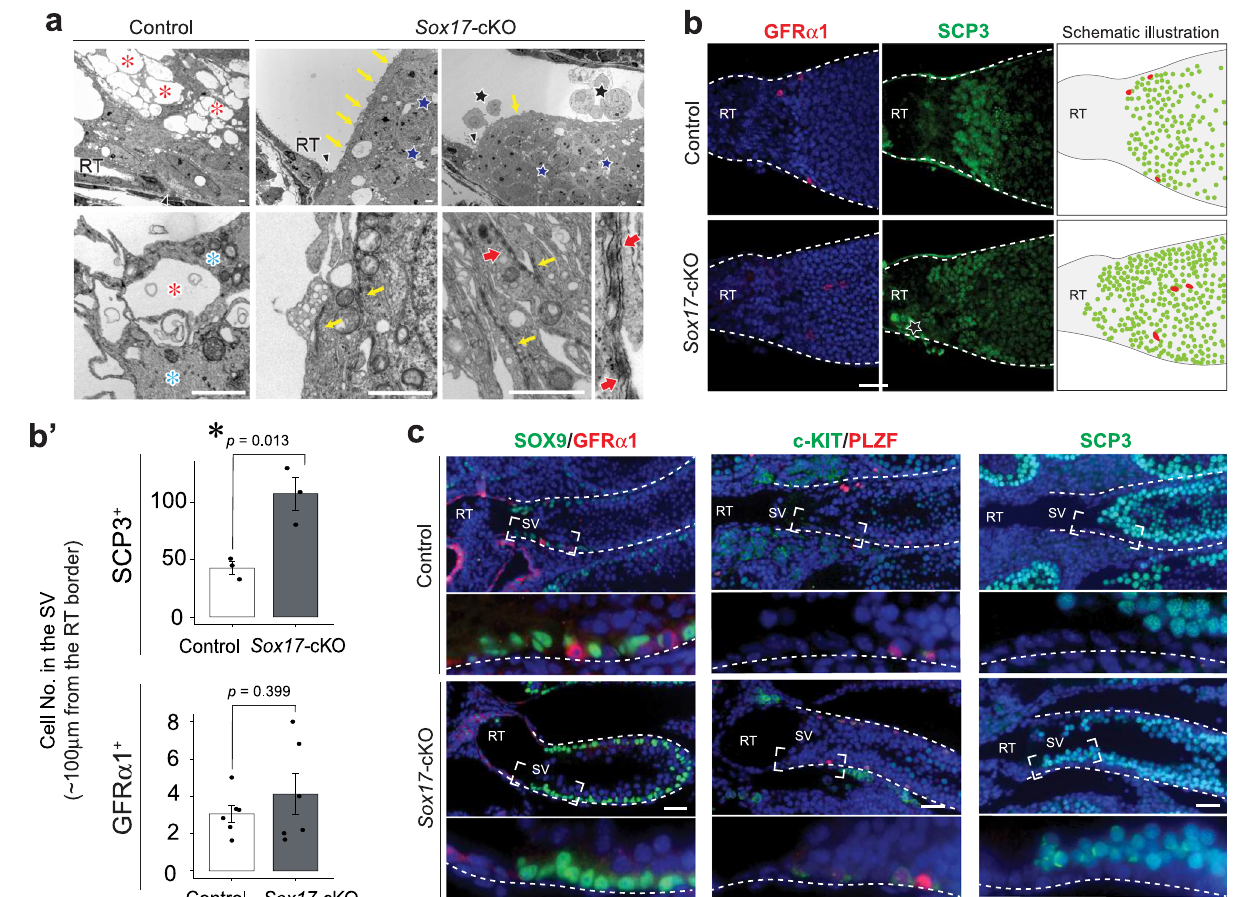
Fig. 2 | Spermatocytes in the SV of Sox17- cKO mice. a Transmission electron microscopy (TEM) of Sertoli cells on the border of the RT. Sertoli cells located within the putative SV region in Sox17- cKO testes harbored spermatocytes (blue stars) packed into apical cell processes with adherence junction (yellow arrows) constructing ectoplasmic specialization (red arrows), which is not normally observed in SV Sertoli cells. In contrast, SV Sertoli cells in the control did not support spermatocytes, and their cytoplasm was enriched with microtubule bun- dles (blue asterisk), forming multiple large vacuoles facing the tubular lumen (red asterisk). b Whole-mount immunohistochemistry of SCP3 (spermatocyte marker) andGFR α 1(A undiff marker)andschematicillustrationoftheSVfragmentswiththeir quanti fi cation( b ′ ).SpermatocyteswereobserveduptotheedgeoftheSVin Sox17- cKO mice, whilethe distribution patternof A undiff in the putative SVregion did not